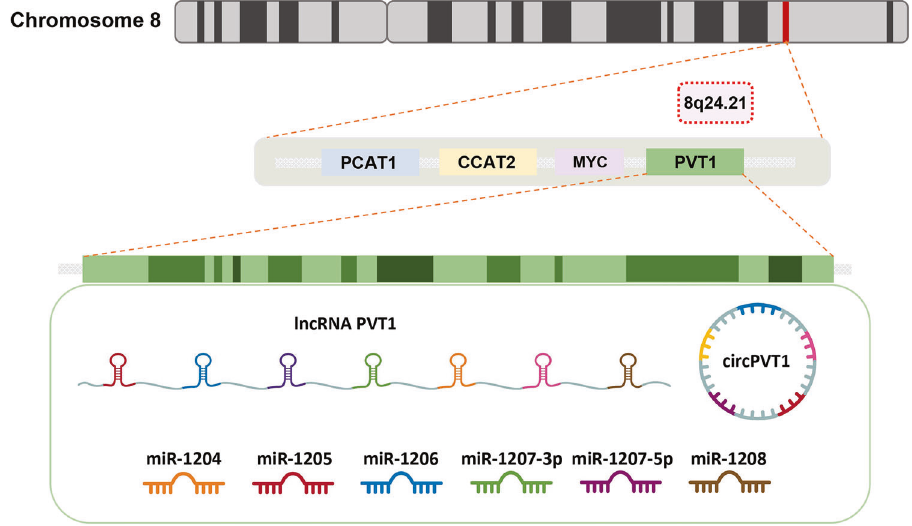
Fig. 1 Structural characteristics of lncRNA PVT1 and